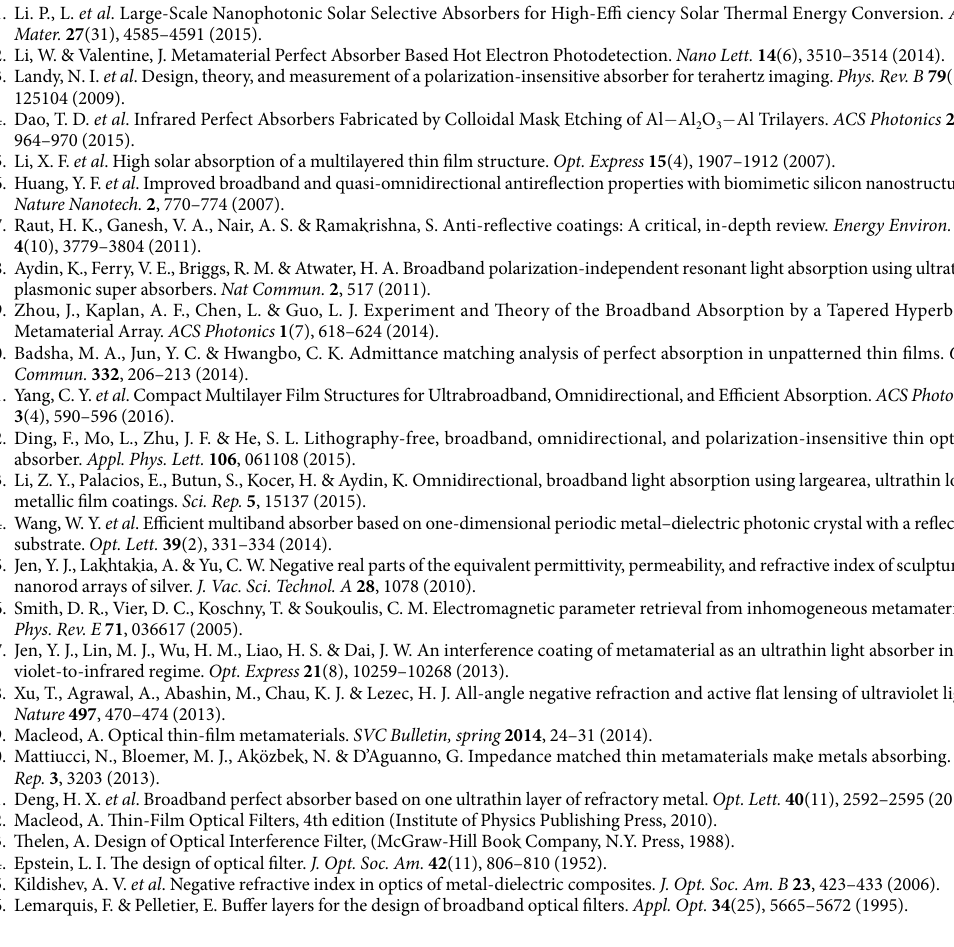
9 Scientific RepoRts | 7: 3076 | DOI:10.1038/s41598-017-03392-7